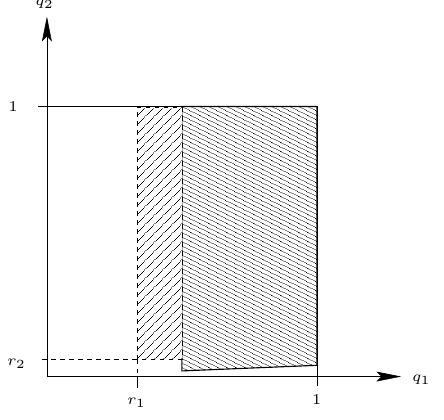
Figure 9. The change to the region in which Ally-Ally is a Nash equilibrium when Player II makes a unilateral commitment to improved market performance, which is then